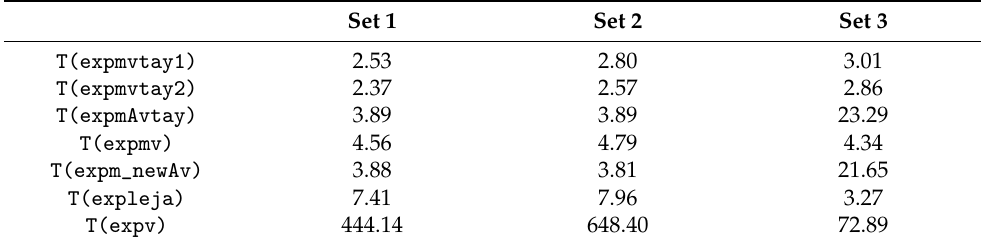
Table 6. Execution time (T), in seconds, spent by all the codes for Sets